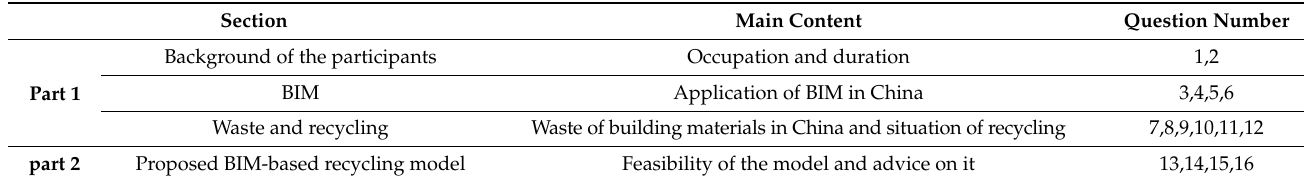
Table 1. Structure of the questionnaire.